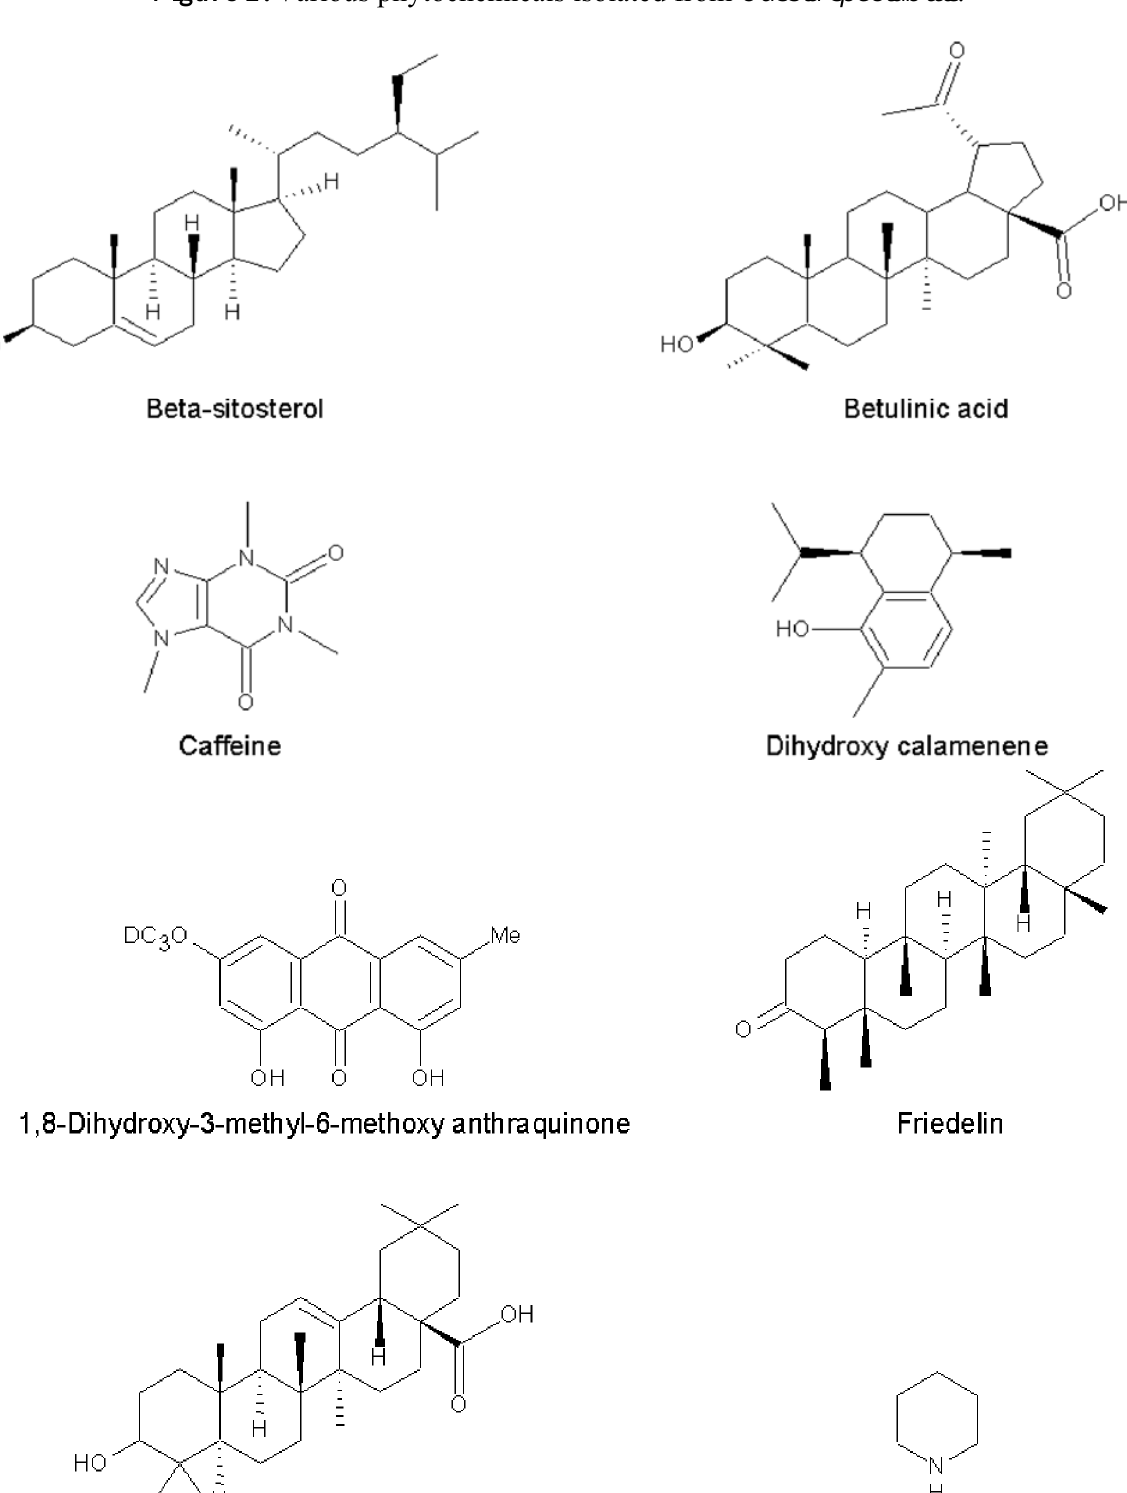
Figure 2. Various phytochemicals isolated from Cassia spectabilis